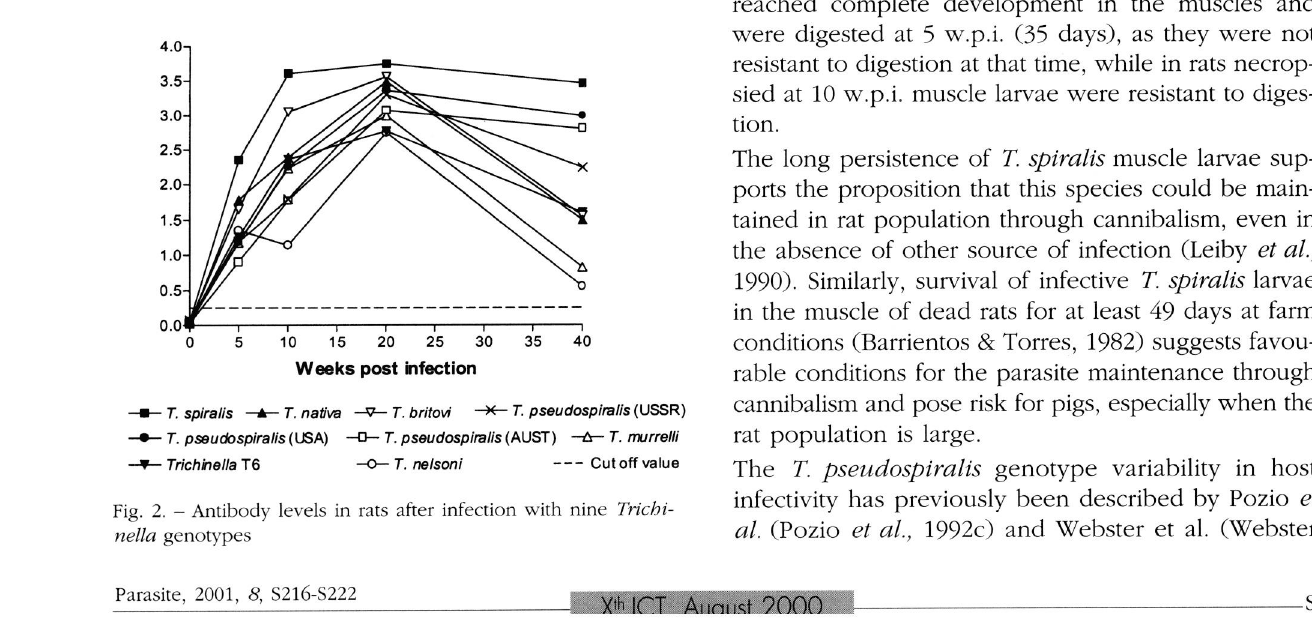
Fig. 2. - Antibody levels in rats after infection with nine Trichi nella